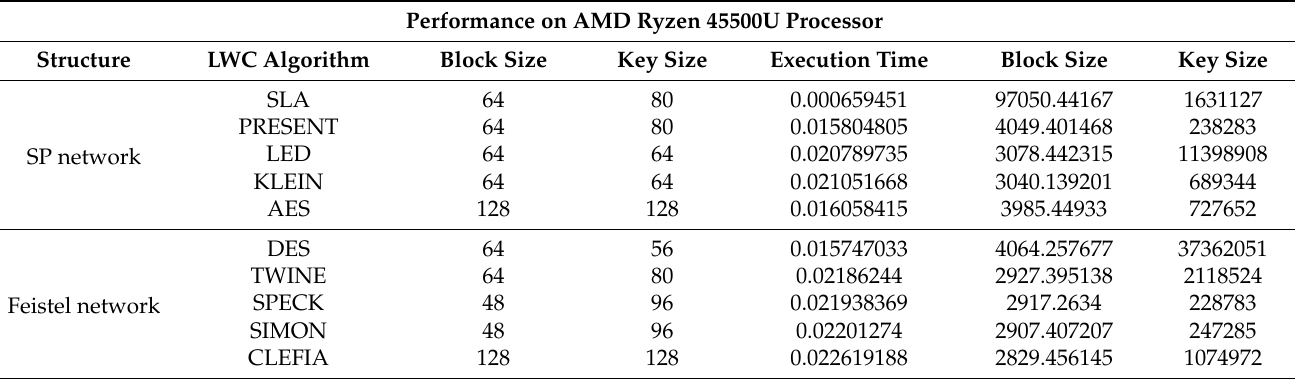
Table 10. The Performance of SLA and Relevant LWC Algorithms in